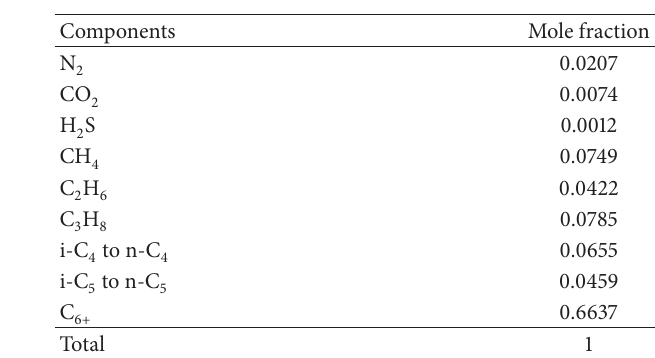
Table 1: Modelled fluid composition for Weyburn